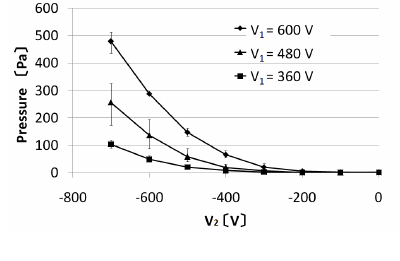
Fig. 11 Mean static pressure as a function of V at various applied 2 voltages of V 1